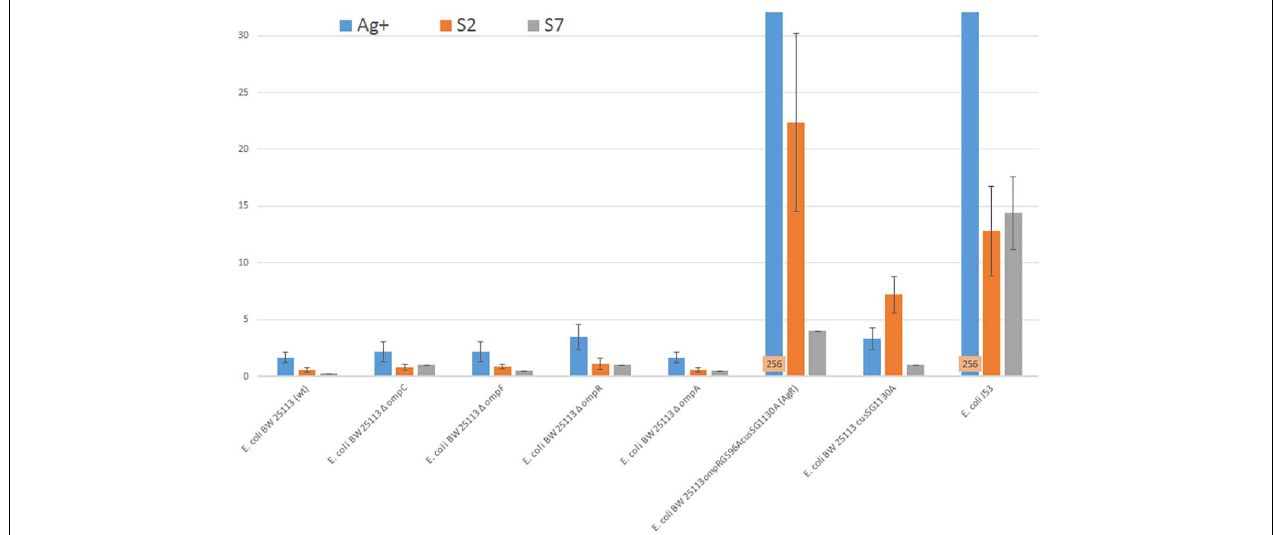
FIGURE 1 | Silver sample’s MIC values of E. coli strains: E. coli J53, E. coli BW25113 (wt) and its